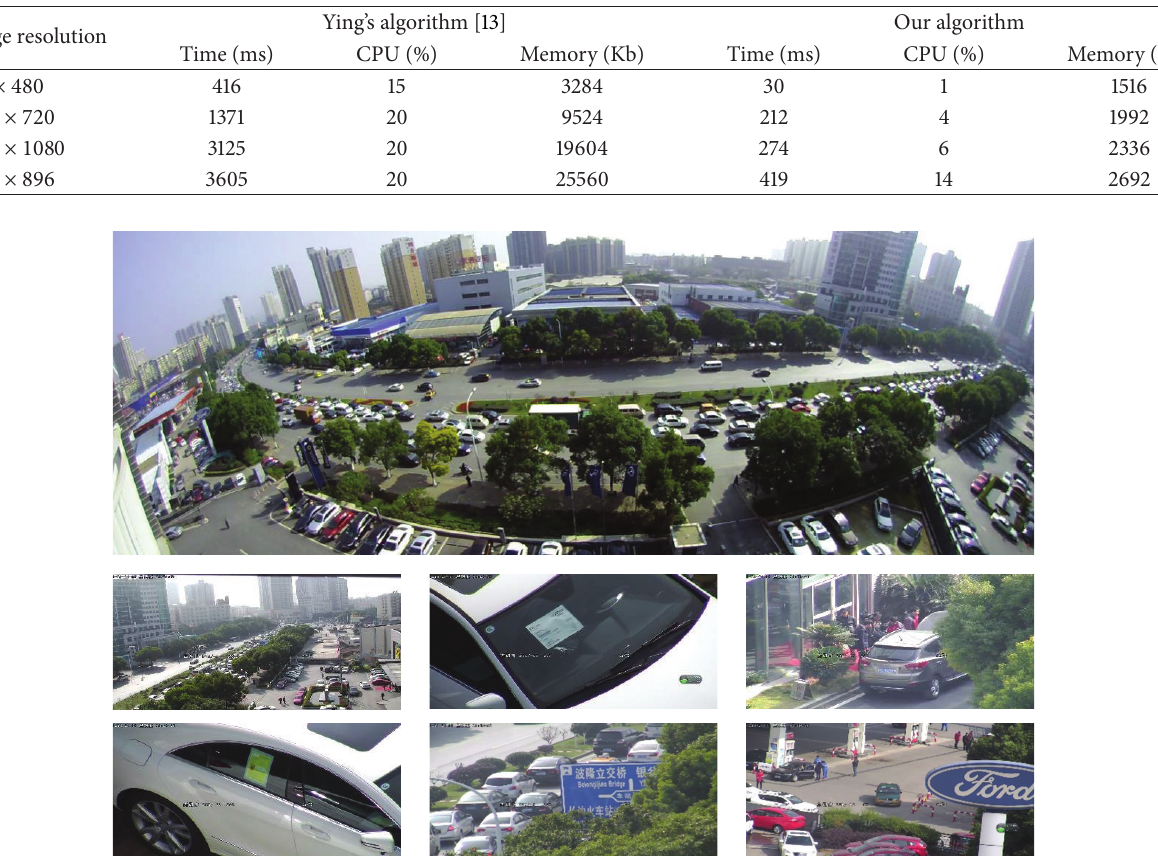
Figure 7: Experimental result after the calibration. Several areas are selected in the panoramic image as focus of interest, and corresponding multiscaled image is captured by PTZ dome camera.